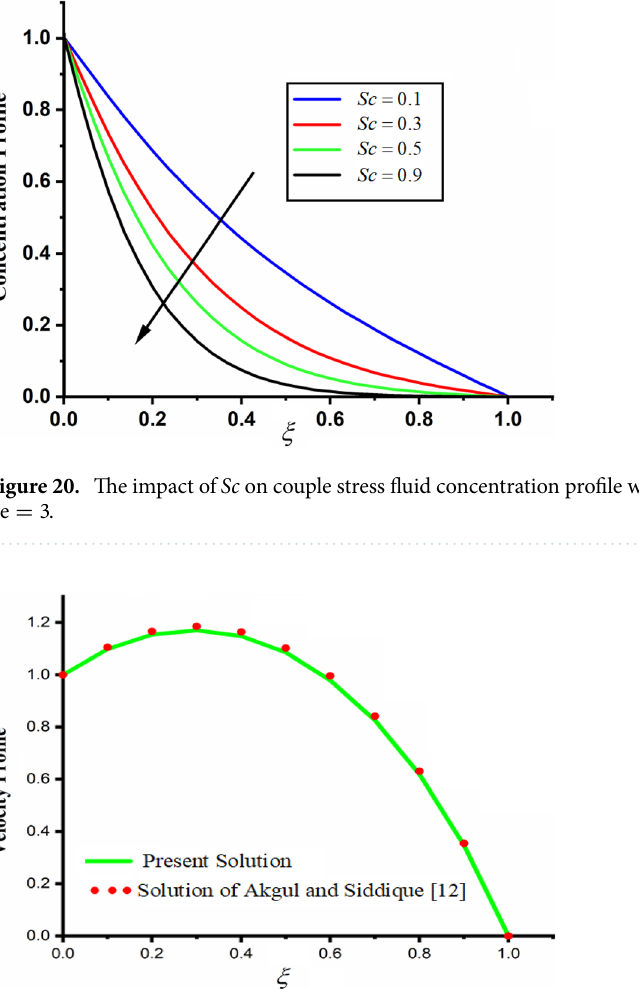
Figure 21. Comparison of the present solution to solution of Akgul and Siddique 12 when, α = 0.5 , β = 0.5 , Gr = 0 , Gm = 0 , M = 2 , 1 → 0 , η A = 1 , P = 0 , Pr = 1.5 , Re = 2.5 and Sc = 0.3 . K